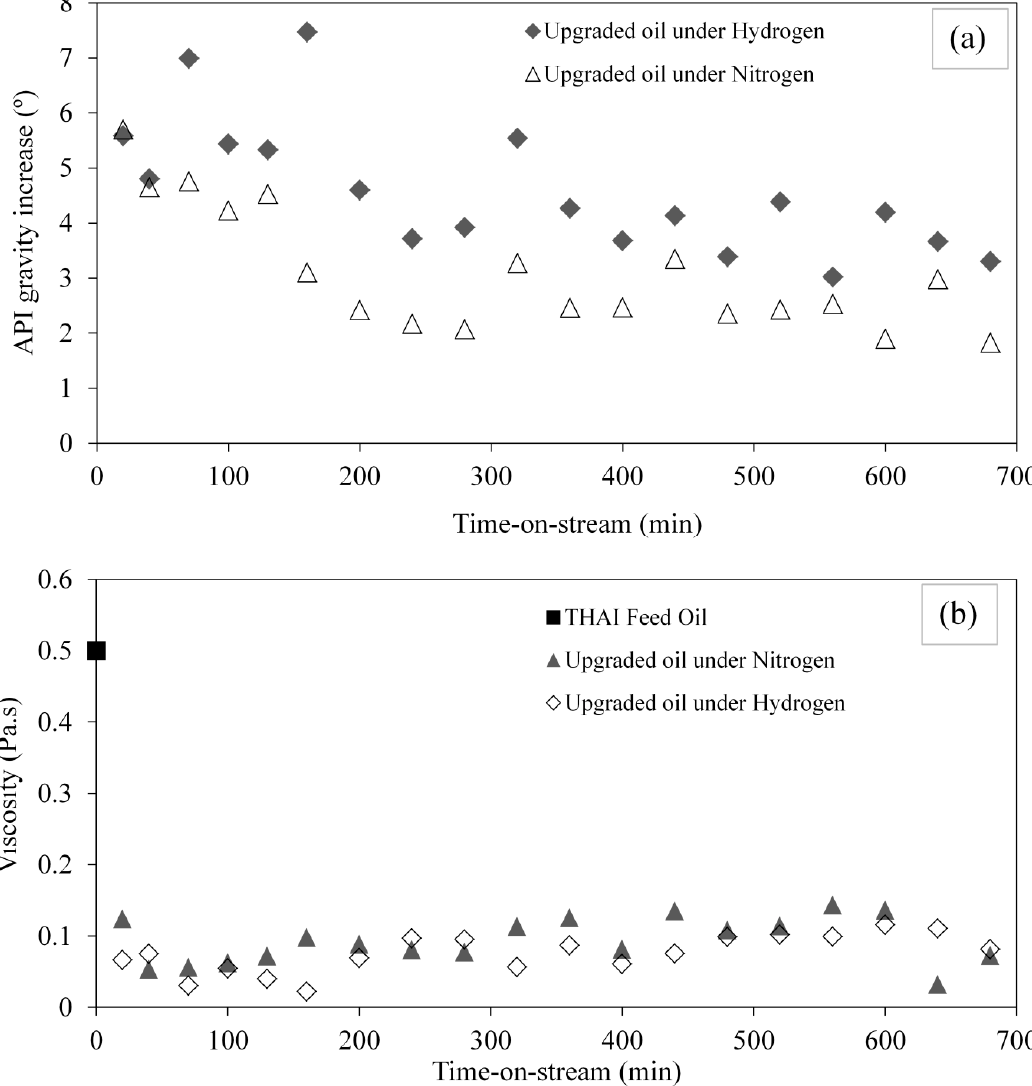
Figure 1. Upgraded oil ( a ) API gravity increase and ( b ) viscosity as a function time ‐ on ‐ stream at temperature 425 °C, pressure 20 barg, LHSV 11.8 h − 1 and GHSV 2353 h − 1 . temperature 425 ◦ C, pressure 20 barg, LHSV 11.8 h − 1 and GHSV 2353 h − 1